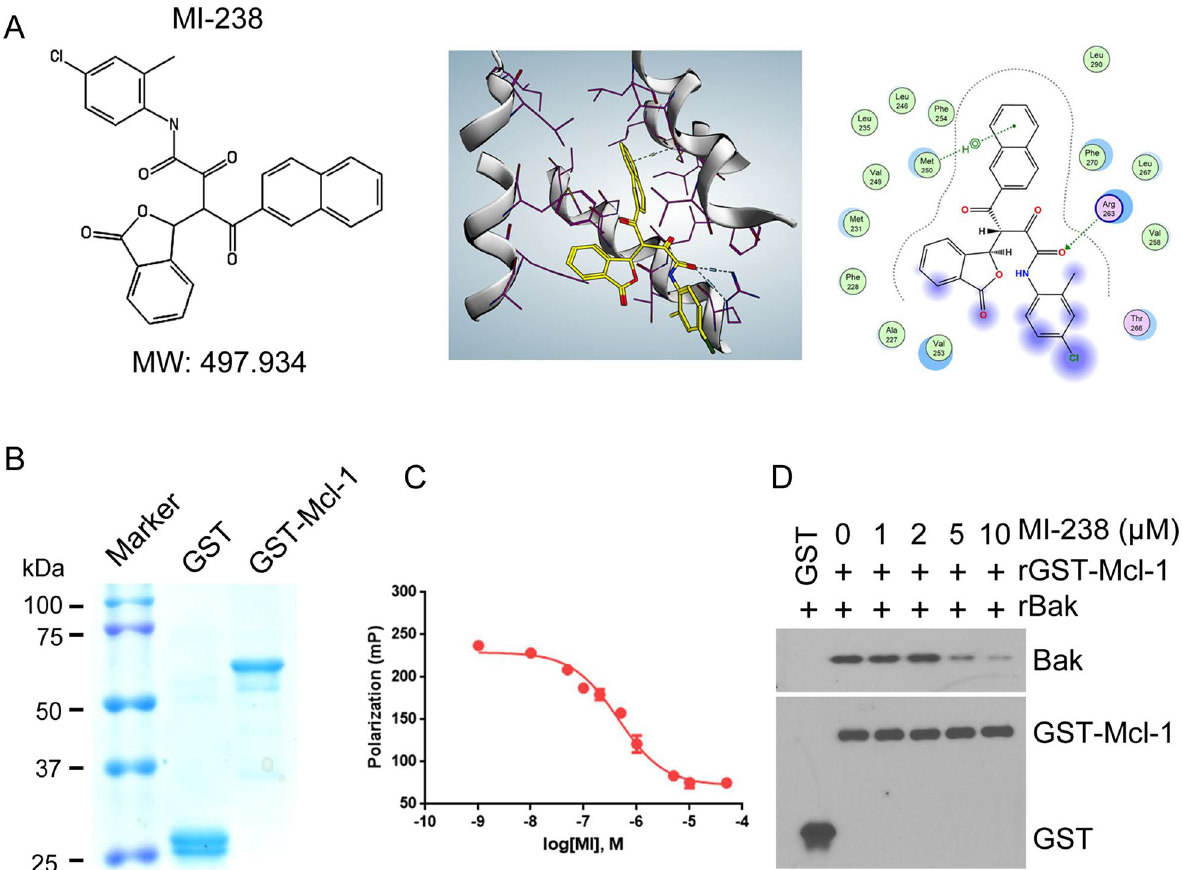
Fig. 1 MI-238 targets Mcl-1 and disrupts Mcl-1/Bak association. A Chemical information and structure modeling of MI-238 in the BH3-binding pocket of Mcl-1 (PDB ID: 4HW3). B Purification of recombinant GST or GST-Mcl-1 proteins. C Fluorescence polarization (FP) assay was performed to measure the binding of MI-238 to recombinant GST-Mcl-1 protein. Data are represented as mean to analyze the association between recombinant GST-Mcl-1 (rGST-Mcl-1) and recombinant Bak (rBak) in presence of increasing concentrations